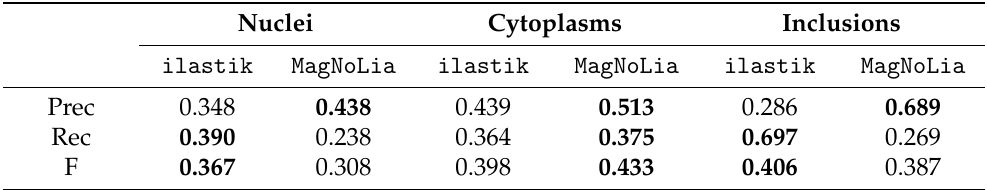
Table 2. Average quantitative results obtained by ilastik and MagNoLia on the images in the ALS- GT dataset for the segmentation of each subregion of an MN. Each row corresponds to a different performance measure, and the best results for each type of subregion and performance measure are put in boldface for better